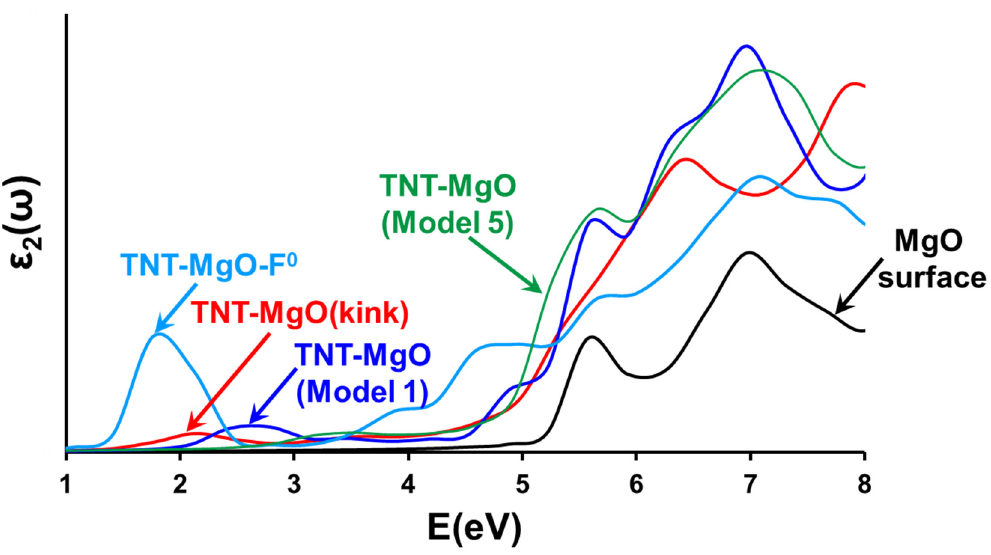
Figure 8. The frequency-dependent, imaginary part of the dielectric function (averaged over the three crystallographic directions) for: a clean (001) MgO surface (black line); a TNT molecule adsorbed at an ideal (001) MgO surface (blue and green lines correspond to Model 1 and Model 5 shown in Figure 4); a TNT molecule adsorbed atop of a kink defect (red line); a TNT molecule adsorbed on top of F 0 -center at an (001) MgO surface (cyan line).